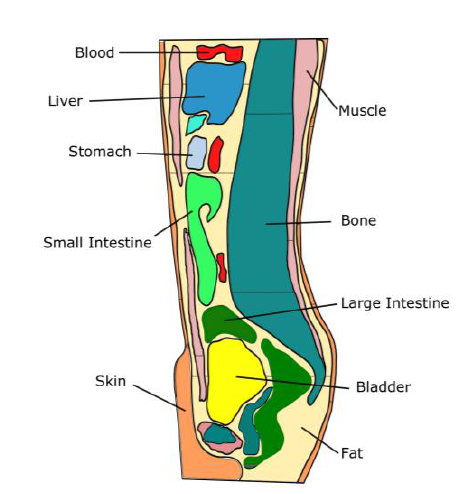
Figure 1: Vertical cross section of human abdomen obtained from Shiba and Higaki [35]